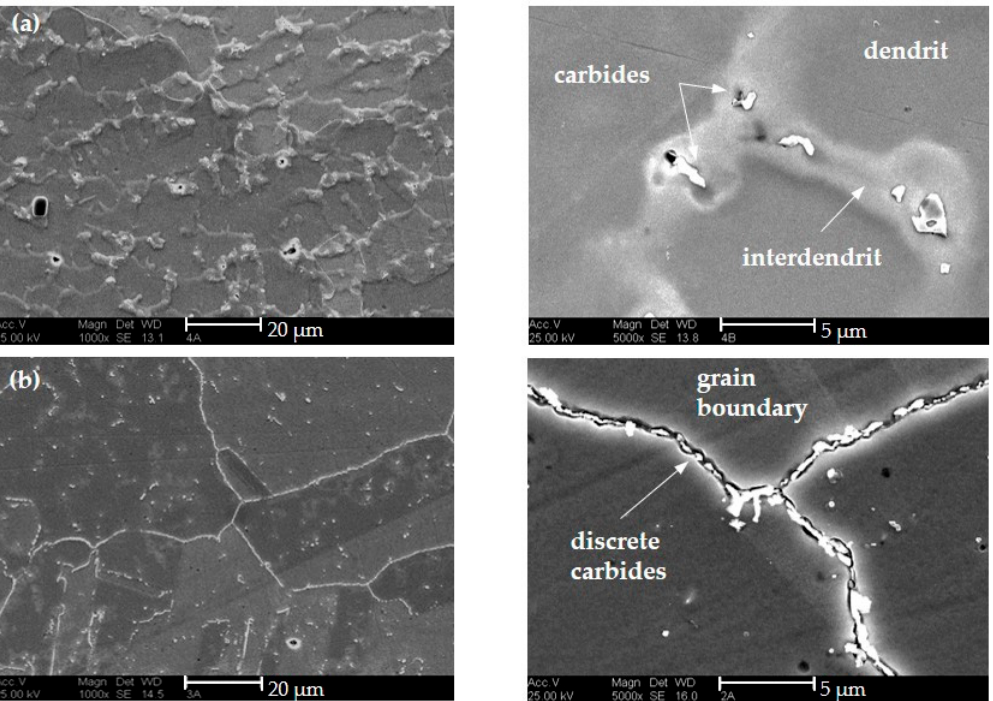
Figure 17. SEM micrographs of specimens, welded with shielding gas Z-ArHeHC. ( a ) as-built; ( b ) precipitation-hardened (etching solution: 5 g C 2 H 2 O 4 dissolved in 95 mL HCl). In addition to the carbides, precipitation of the γ -phase occurs, as expected (Figure 18).